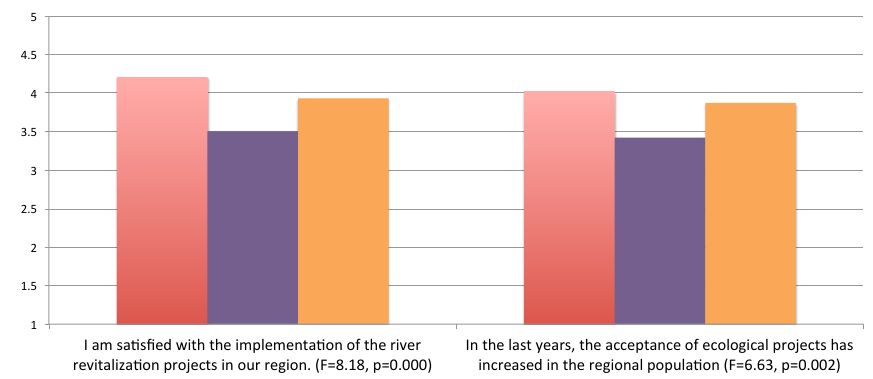
Fig. 4. Swiss inhabitants’ agreement with statements related to their or their region’s acceptance of ecological enhancement projects differen- tiated between groups with and without reported stakeholder involvement in their region. Comparison of mean values (ANOVA). N = 230. The interviews with the former advisory board